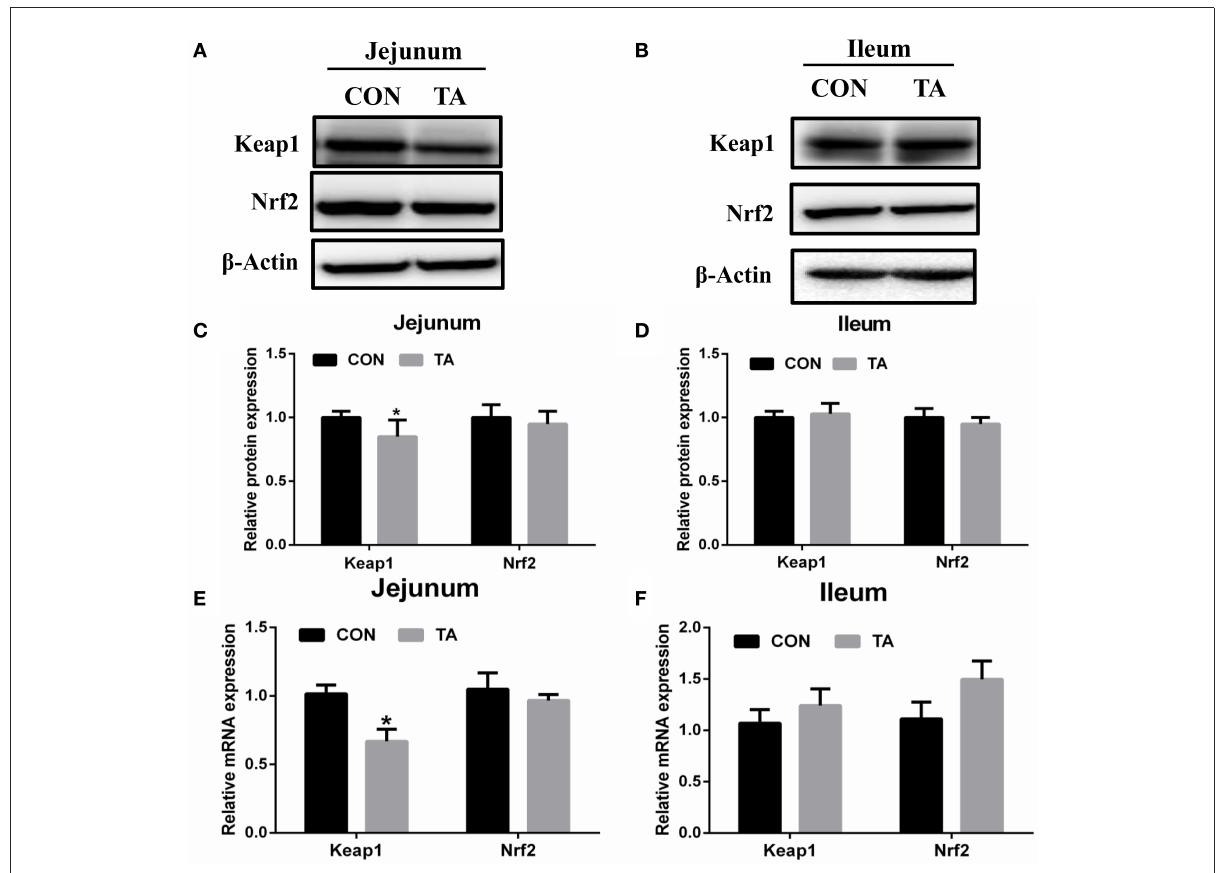
FIGURE1 Effects of tannic acid (TA) on the Nrf2-Keap1 pathway in weaning piglets. The relative protein levels of the Nrf2-Keap1 pathway in the jejunum (A) and in the ileum (B) . Quantitative analysis of the relative protein levels of Keap1 and Nrf2 in the jejunum (C) and in the ileum (D) . The relative mRNA levels of Keap1 and Nrf2 in the jejunum (E) and in the ileum (F) . CON, basic diet; TA, a basic diet supplemented with 1,000 mg/kg tannic acid. Data are presented as mean ± SEM, n = 9. * P < 0.05. * means comparing to the CON